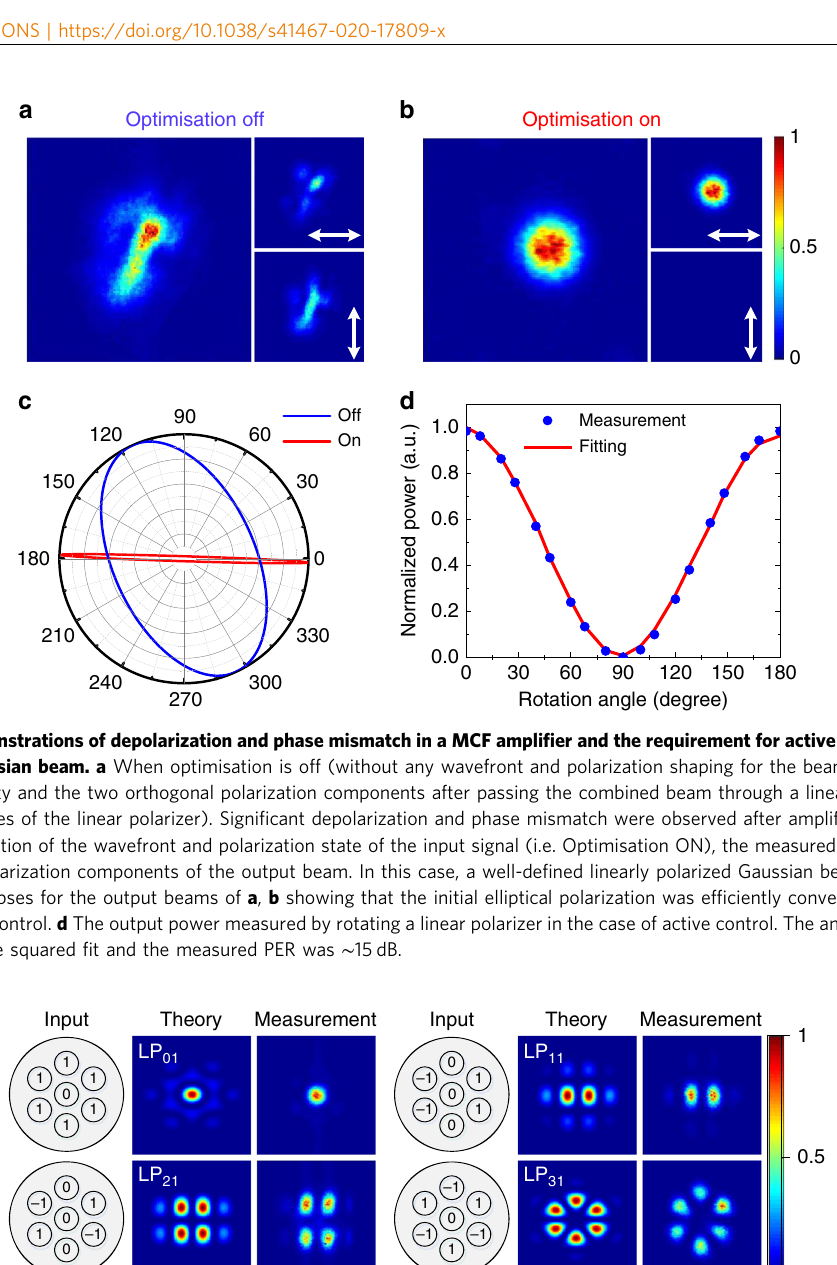
the output beam is a radially polarized vector beam. With α